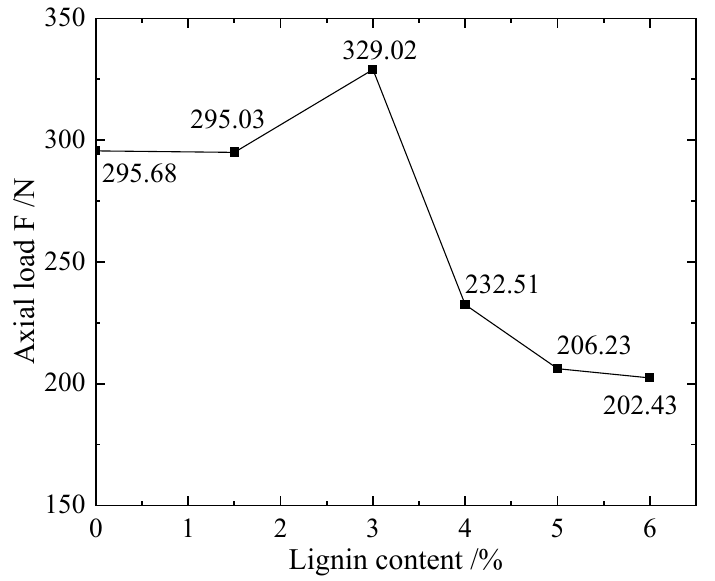
Figure 8. Sample of L scheme: lignin addition ratio and axial load F diagram.